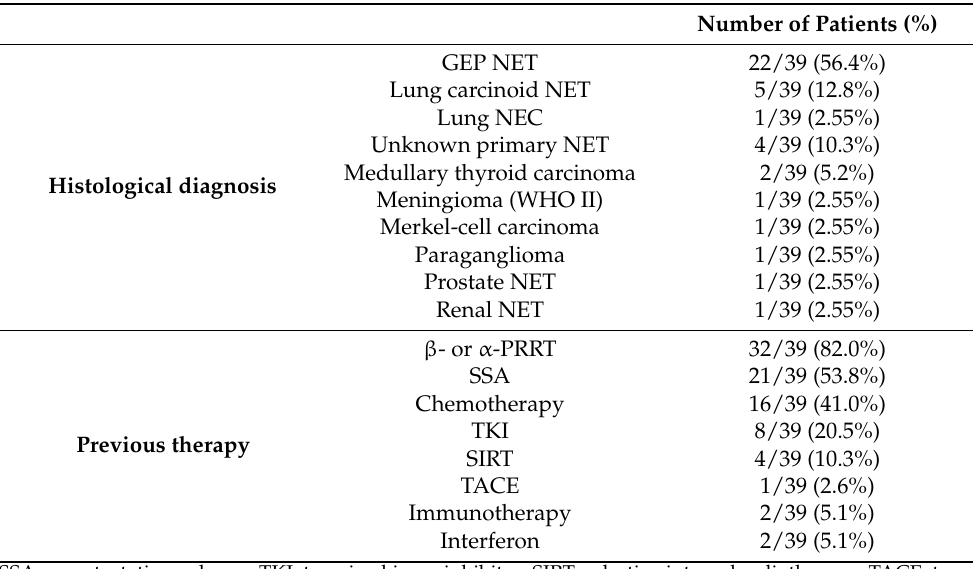
Table 2. Histological diagnosis of the 39 patients reported by Kratochwil et al. and details of the prior systemic treatments for the 37 pretreated patients